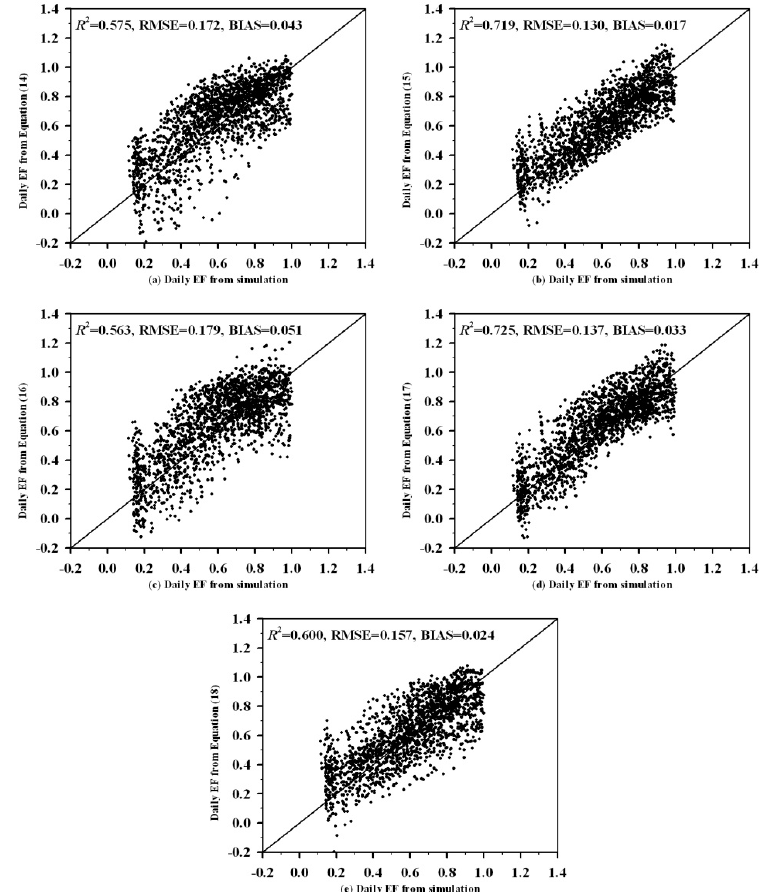
Figure 10. Comparisons of daily EF estimated by Equations (14–18) with ALEX-simulated actual values based on 35 atmospheric conditions from four sites (( a ) is for the inputs of change rate during the morning, ( b ) is for the differences between Aqua daytime and nighttime, ( c ) is for the differences between Terra daytime and nighttime, ( d ) is for the differences between Terra daytime and Aqua nighttime, and for the differences between Aqua daytime and Terra